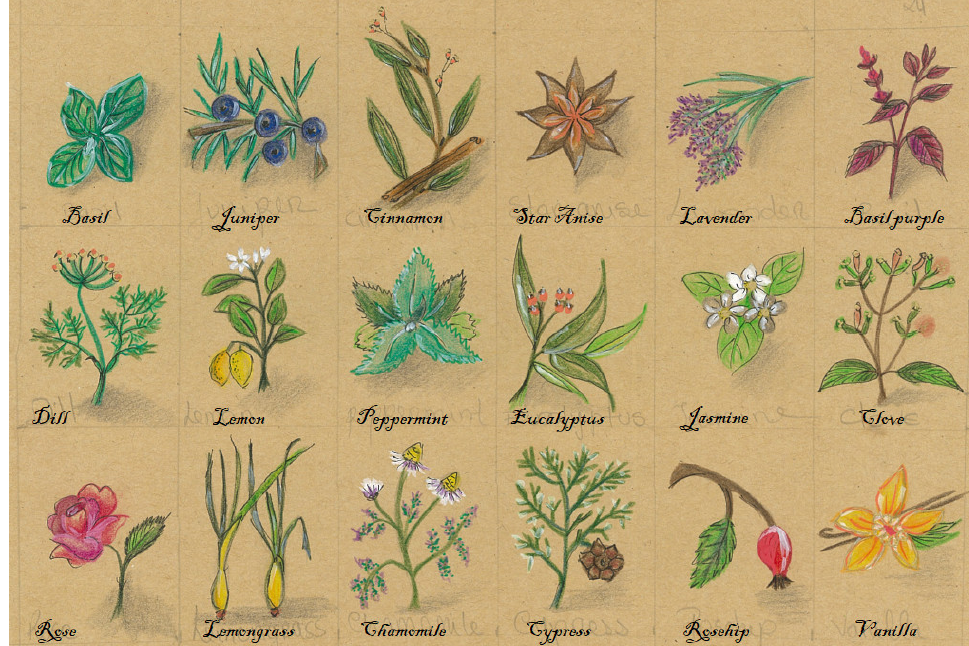
Figure 1. Representation of different EO-producing aromatic plants (author ICN).